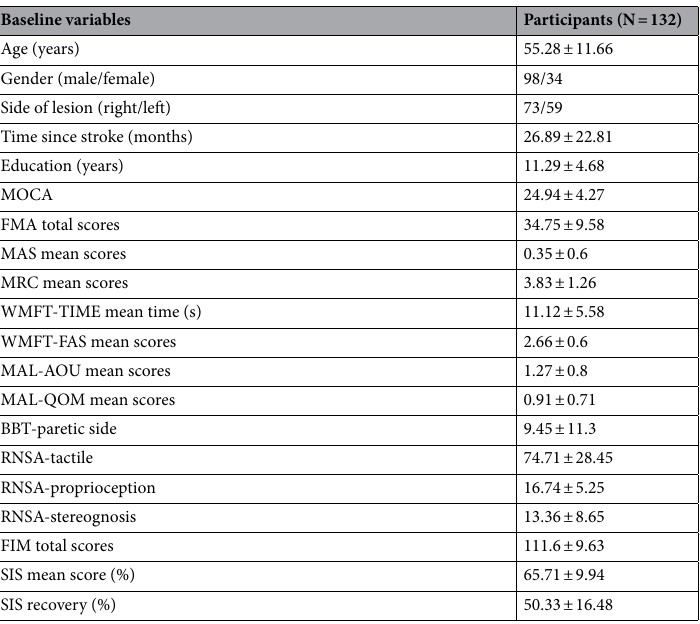
Table 1. Clinical characteristics of participants. MOCA Montreal Cognitive Assessment assessing global cognitive function (total scores:30), FMA Fugl-Meyer Assessment Scale of Upper Extremity assessing motor impairment of the upper extremity (total scores:66), MAS Modified Ashworth Scale assessing muscle tone level of the upper extremity (item score range:0–4, the MAS mean scores were the average scores of all parts of upper extremity), MRC Medical Research Council Scale for muscle strength assessing muscle strength of the upper extremity (item score range:0–5, the MRC mean scores were the average scores of all parts of upper extremity), WMFT-TIME Wolf Motor Function Test TIME-representing movement efficiency of the upper extremity (WMFT-TIME mean scores are the average time of all test items, Unit = seconds), WMFT- FAS Wolf Motor Function Test-functional ability scale representing motor function of the upper extremity (item score range 0–5; WMFT-FAS mean scores are the average scores of all test items), MAL AOU motor activity log-amount of use representing participants’ self-perceived amount of use of the paretic arm (item score range:0–5; MAL-AOU mean scores are the average scores of all test item), MAL QOM motor activity log-quality of movement representing participants’ self-perceived quality of paretic arm movements (item score range:0–5; MAL-AOU mean scores are the average scores of all test item), BBT-Paretic Box and Block Test-Paretic representing the paretic hand function (total scores = 150 (150 cubes), RNSA Revised Nottingham Sensation Assessment assessing the tactile, proprioception, and stereognosis sensation of the paretic side of the body (item score range: 0–2; unable to test = 9), FIM functional independence measure assessing participants’ levels of disability (item score range: 1–7; total score:18–126), SIS stroke impact scale. Value is mean ± standard